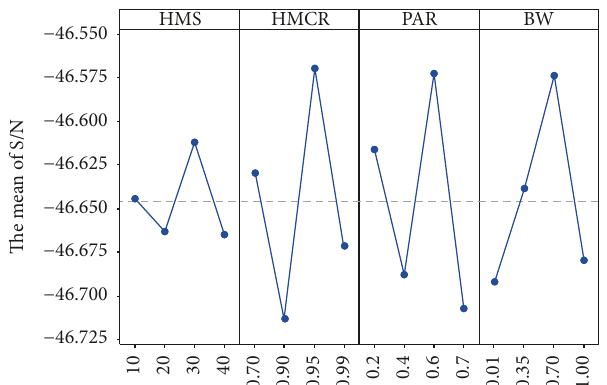
Figure 9: Main effects plot for S/N ratios of HS factors.